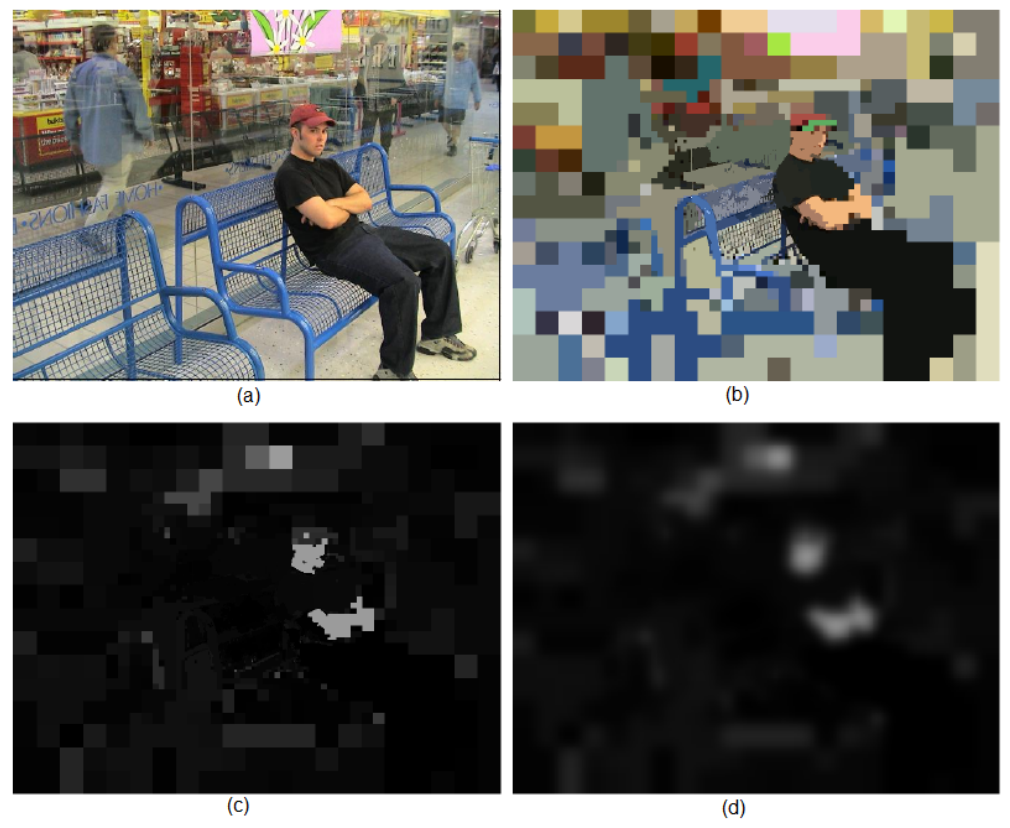
Figure 17. ( a ) Image #67 of the Toronto database; ( b ) Segmentation provided by the BD3P (centered fovea of 176 × 140 pixels and five resolution rings); ( c ) Saliency map provided by the attention model ( λ = { 0.2,0.2,0.2,0.2,0.2 } ); and ( d ) Density map obtained by Gaussian smoothing ( σ =